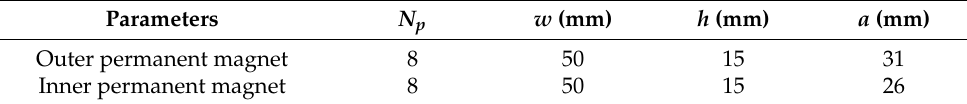
Figure 6. The fitness curve of the total objective function. After PSO optimization, the corresponding values of the axial length, circumferential width, and radial height of the inner and outer permanent magnets are shown in Table 2. Table 2. Main parameter values of the optimized permanent magnets.